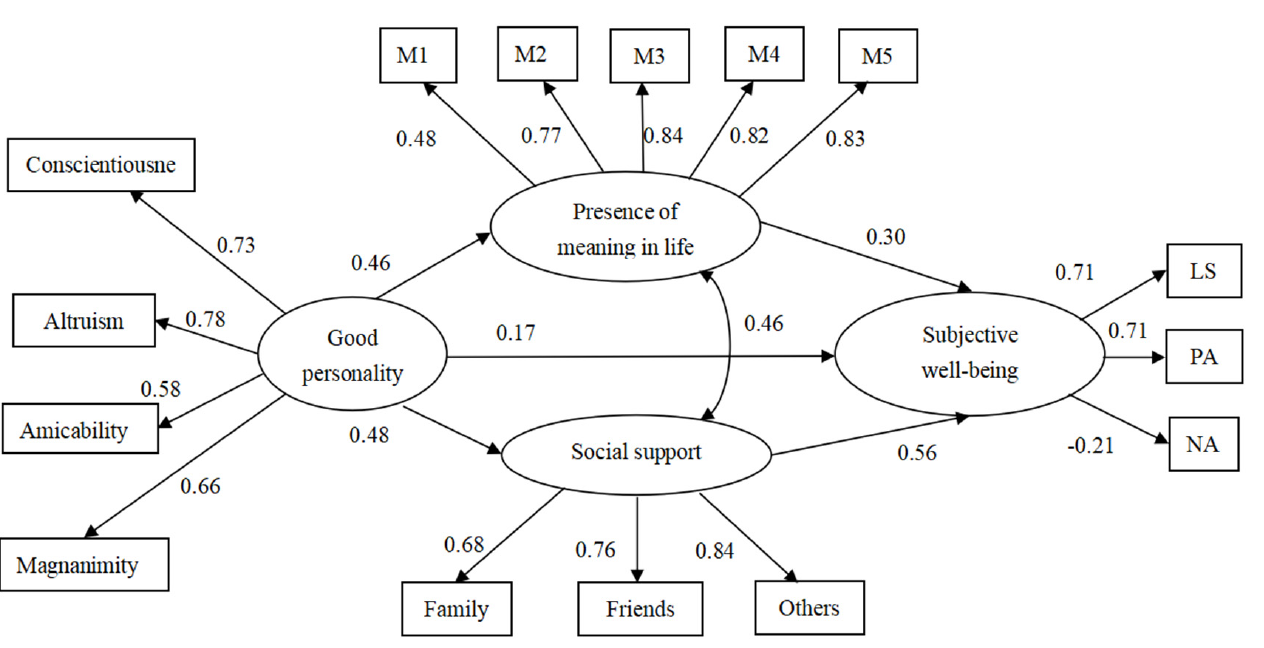
Table 7. Results of indirect effect analysis of Model 2.